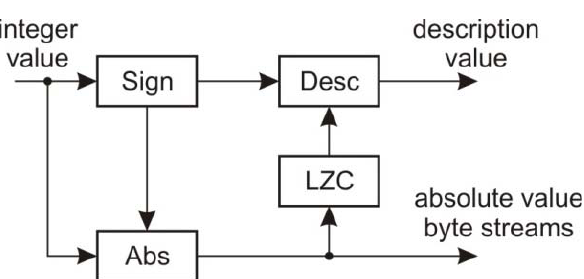
Figure 8. Variable length